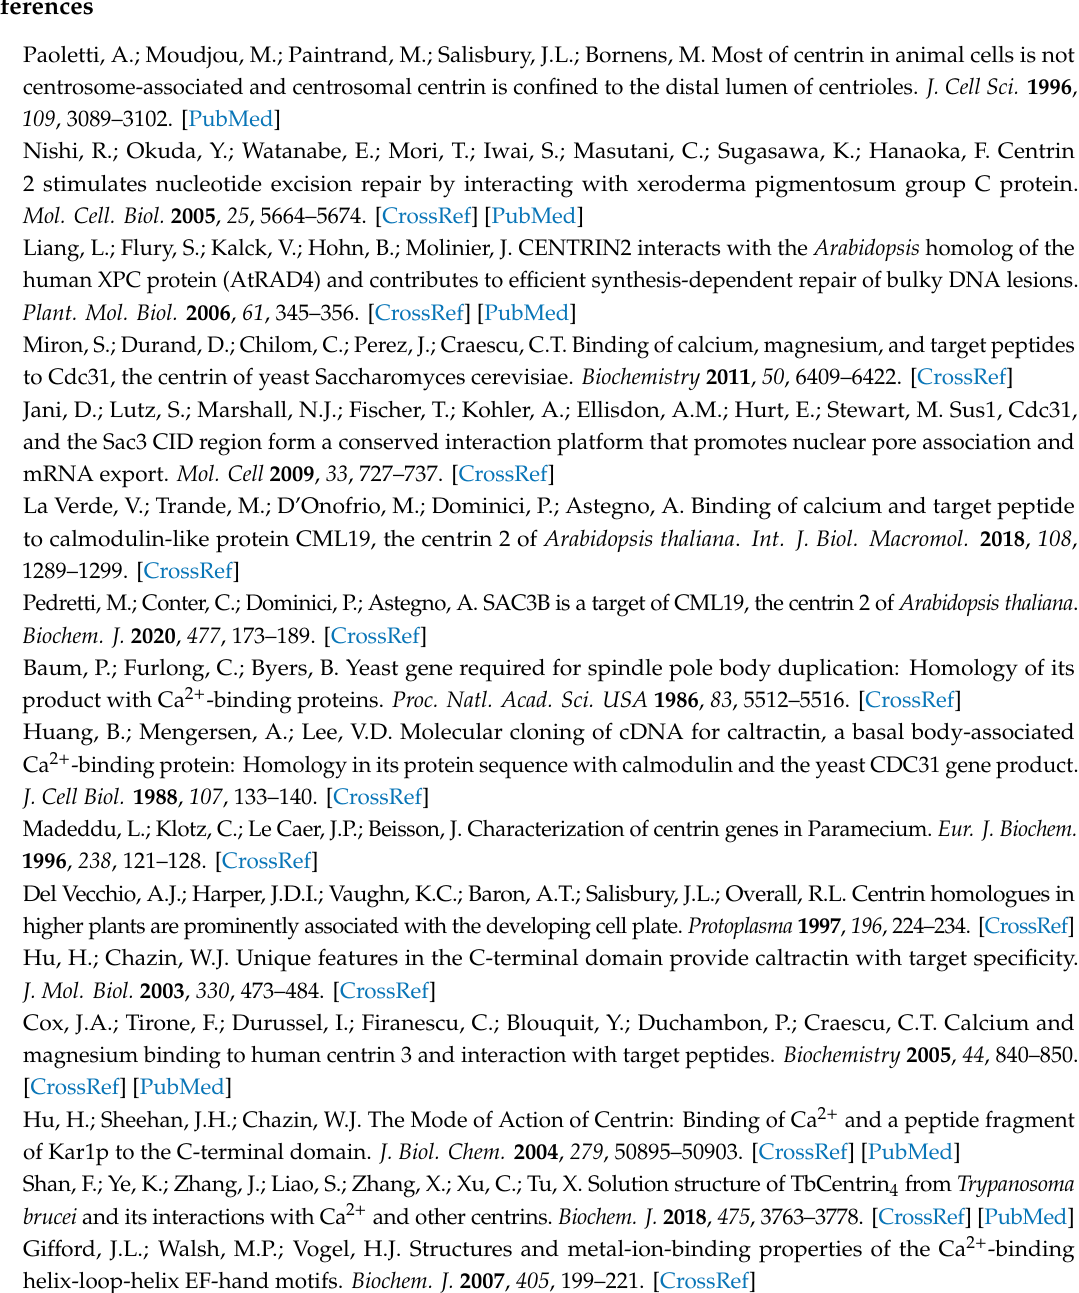
HSQC NMR spectra of full-length TgCEN2; Figure S3: 1 H- 15 N HSQC NMR spectra of TgCEN1-C and TgCEN2-C in the presence of MgCl2, Figure S4: Far-UV CD spectra of TgCEN1-C and TgCEN2-C in the presence of MgCl 2 , Figure S5: Fluorescence emission of ANS in the presence of MgCl 2 , Figure S6: Dependence on ionic strength of self-assembly